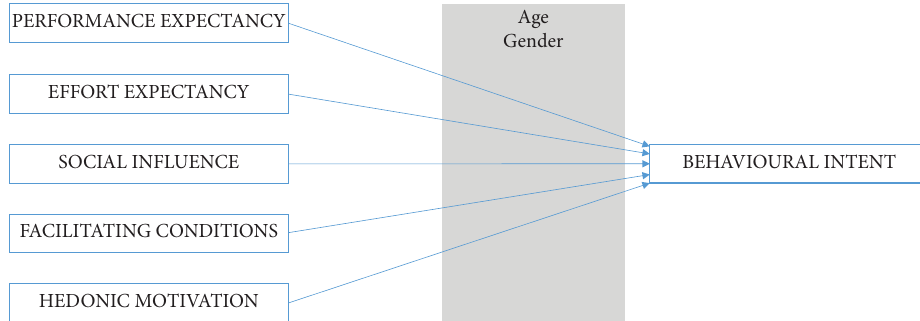
Figure 1: Illustration of the UTAUT2-framework and its latent constructs. Items in gray are predictors of class types. Table 1: Statistical ft for questions, leading on to the latent